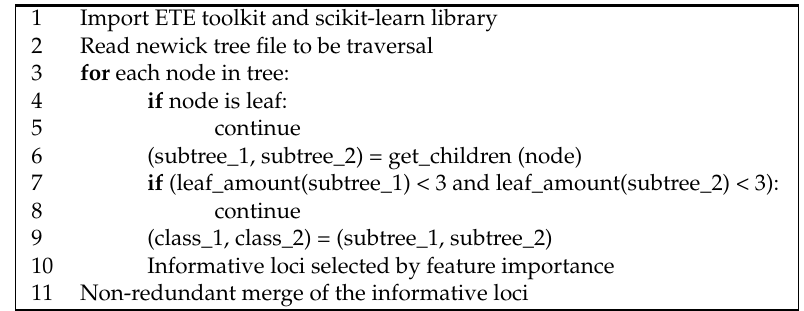
Table 1. The Loci Extractor